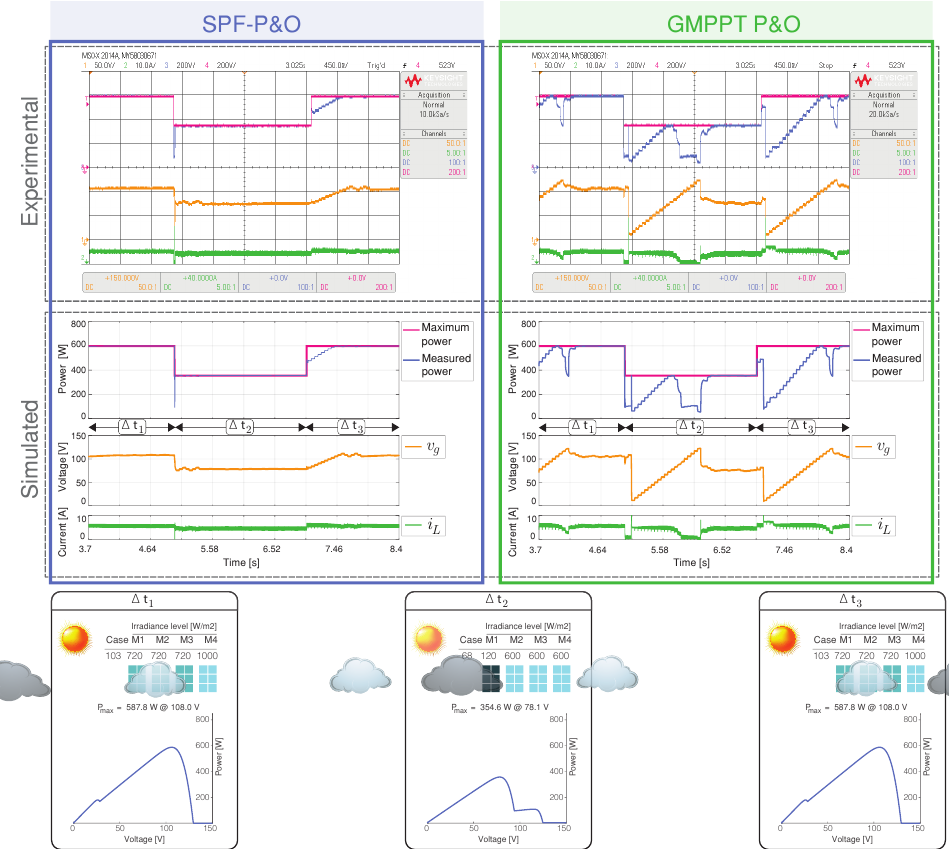
Figure 9. Simulated and experimental dynamic behavior of the MPPT algorithms for Scenario 3 with an output voltage V o = 160 V. The proposed MPPT algorithm (right) is compared with the GMPPT P&O algorithm (right). CH1: v g (50 V/div), CH2: i L (10 A/div), CH3: Maximum power (200 W/div), CH4: Measured power (200 W/div) and a time base of 450 ms. RE